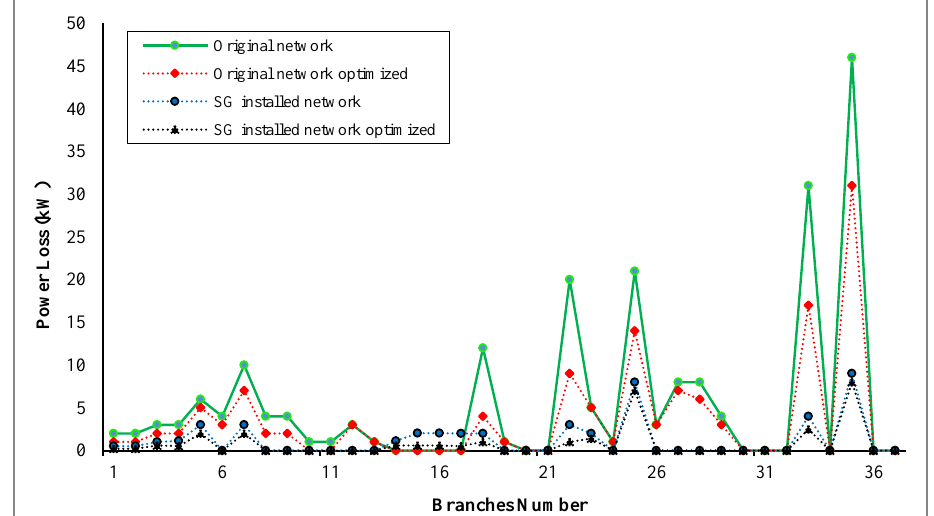
Figure 7. Power loss dispersion of IEEE model distribution network